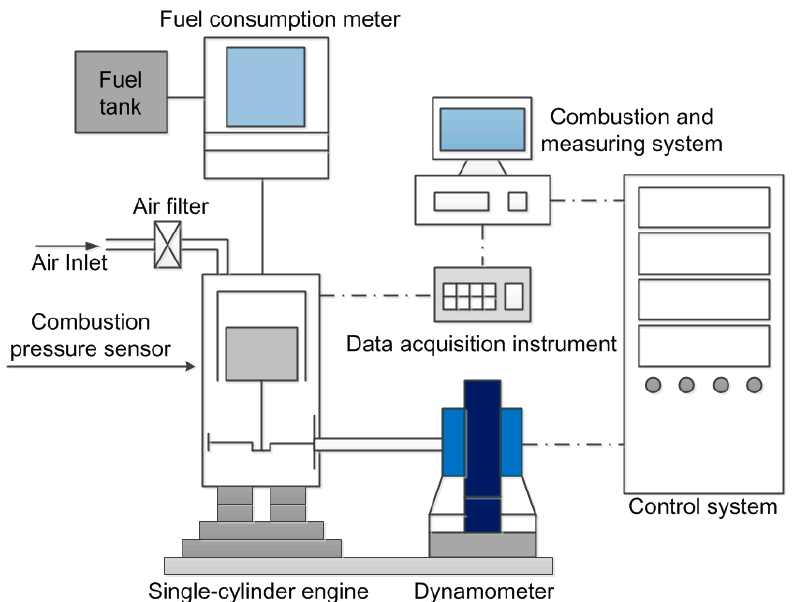
Figure 12. Schematic diagram of engine test bench. Table 3. Accuracy and uncertainty of the measuring equipment.